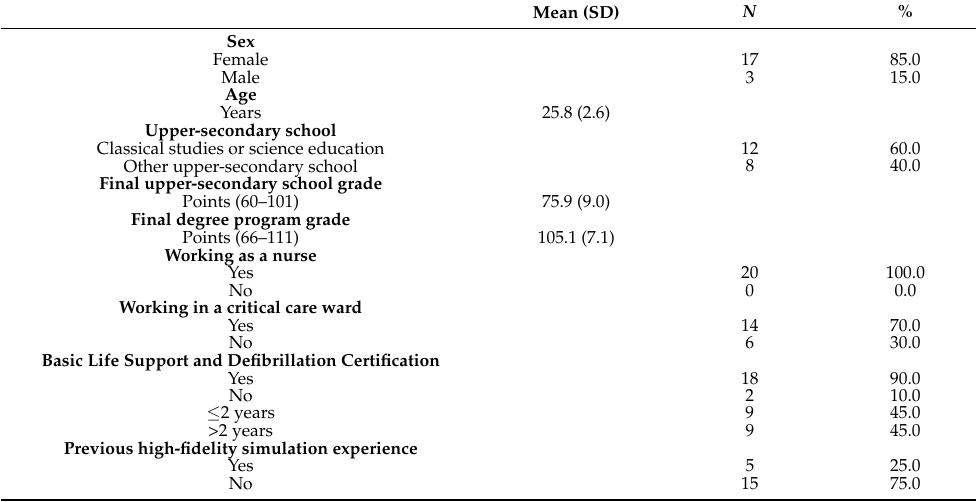
Table 1. Participants’ characteristics ( n =